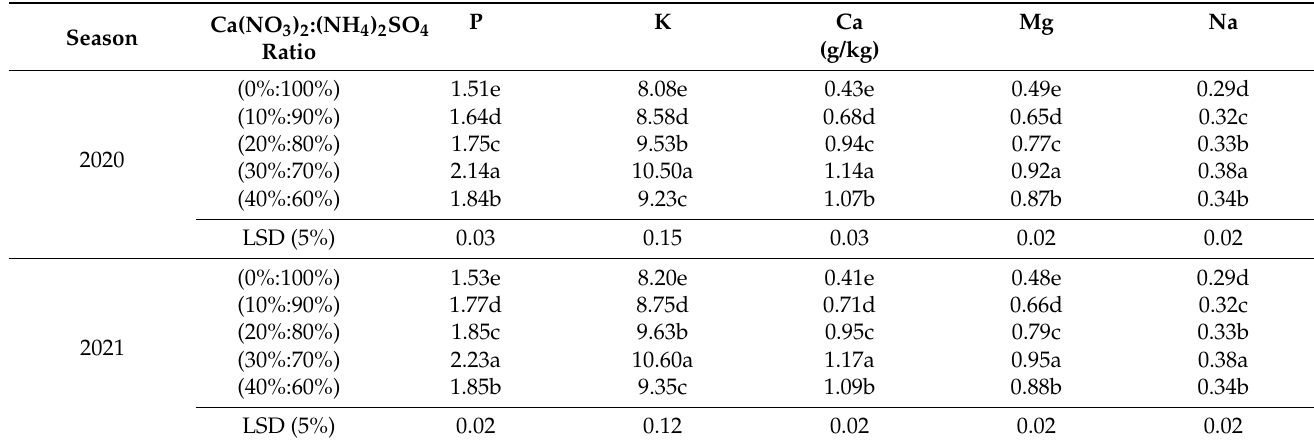
Table 6. The impact of Ca(NO 3 ) 2: (NH 4 ) 2 SO 4 ratios on P, K, Ca, Mg, and Na, of the pomegranate fruits of cv. ‘Wonderful’ in 2020 and 2021 seasons.